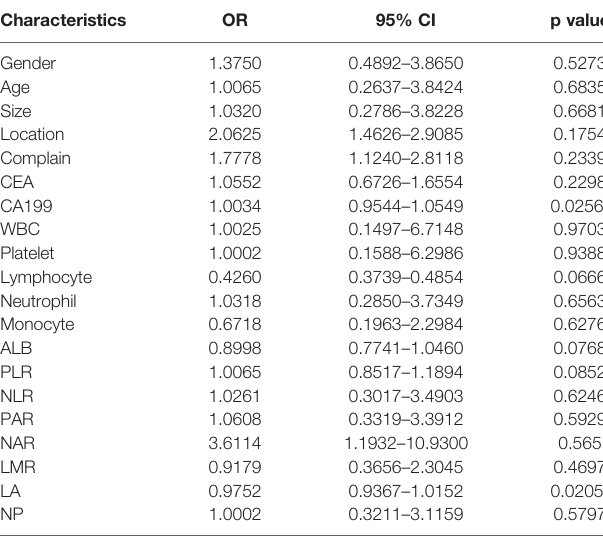
TABLE 2 | Univariate analysis of risk factors associated with